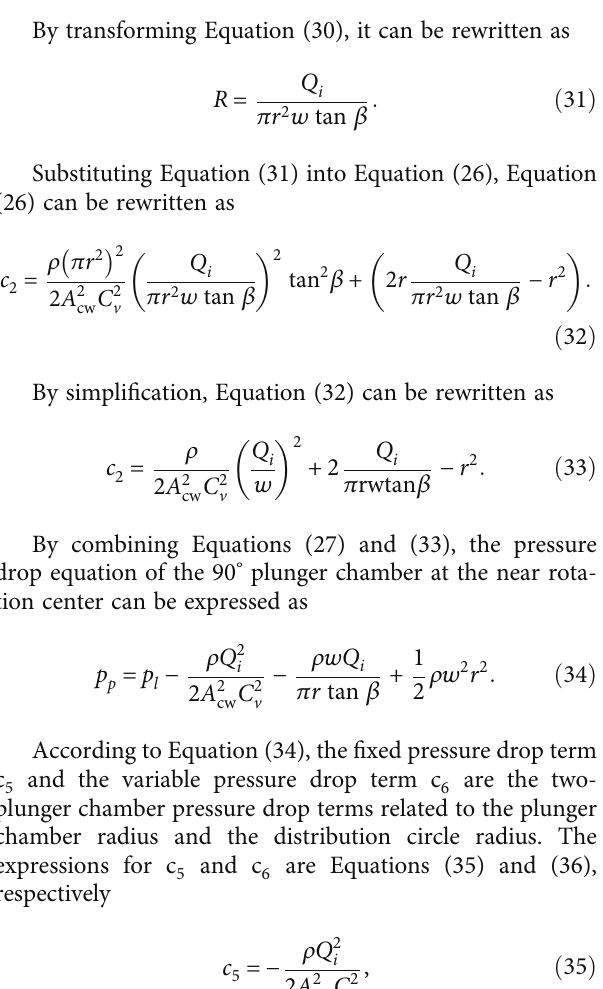
Figure 4: The relationship curves between the plunger chamber radius, the rotation speed, and the variable pressure drop term.